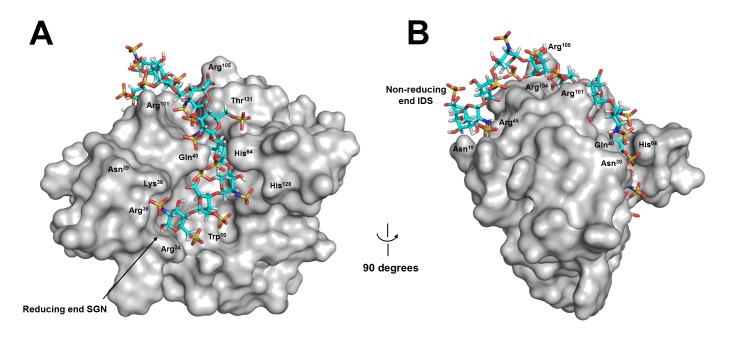
Predicted wtECP-Hep12 interaction.Hep12 bound to wtECP with the lowest energy. The ligand was shown in stick. (A) and (B) respectively represented a front and a side view of wtECP-Hep12 complex. Amino acids that interacted with the bound Hep12 on the surface were indicated by residue numbers. SGN, 6-O-sulfated, N-sulfated glucosamine; IDS, 2-O-sulfated iduronic acid.